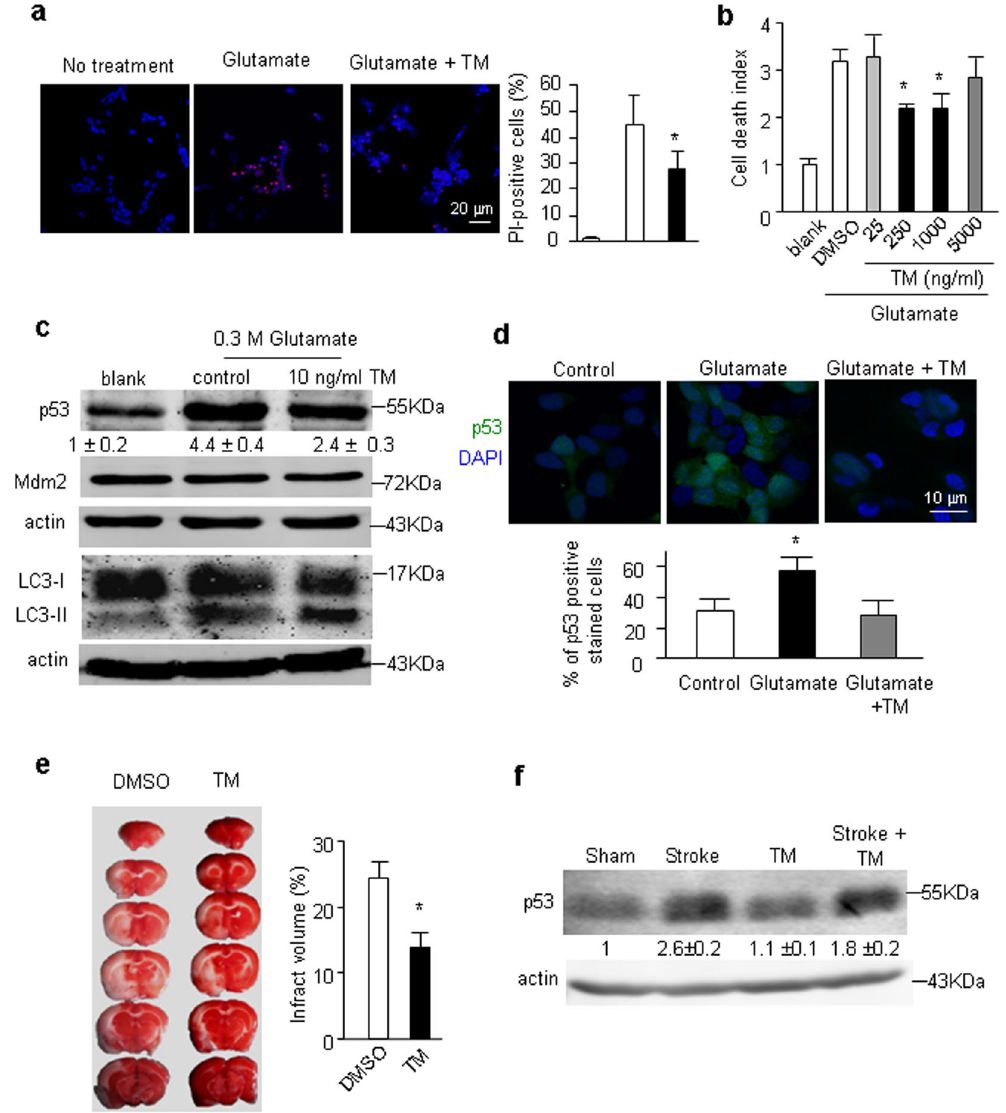
Figure 5. Effect of ER stress on neuronal necrosis and stroke. ( a ) Effect of TM on glutamate-induced cell death in SH-SY5Y cells. The cell death was determined by PI staining. The statistic result is shown on the bar graph. Trial n = 4. ( b ) Effect of TM on glutamate-induced cell death in SH-SY5Y cells. The cell death was determined by the ATP assay. Trial n = 4. ( c ) Protein level of p53 and the active state of autophagy. The result showed that TM treatment reduced p53 accumulation upon glutamate treatment and autophagy was activated as shown by the increased LC3-II level. The Mdm2 protein level shows no change. Trail n = 3. ( d ) Immunofluorescent staining of p53 in SH-SY5Y cells. DAPI labels DNA. The bar graph shows the percentages of p53 positive cells from 3 independent experiments. ( e ) Effect of TM (dissolved in DMSO) on the rat MCAO model. Injection of DMSO is the sham control. The white areas of TTC-stained images show the levels of brain damage. The quantitative data is shown in the bar graph. Five rats were tested for each condition. ( f ) Protein level of p53 detected by Western blot under conditions indicated. Trial n =